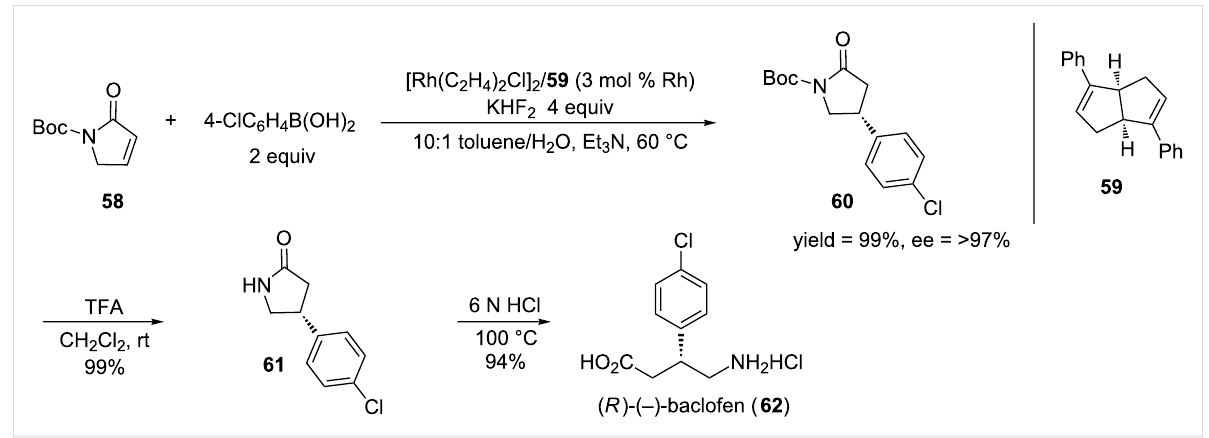
Scheme 16: Synthesis of ( R )-( − )-baclofen through a rhodium-catalyzed asymmetric 1,4-arylation of lactam 58